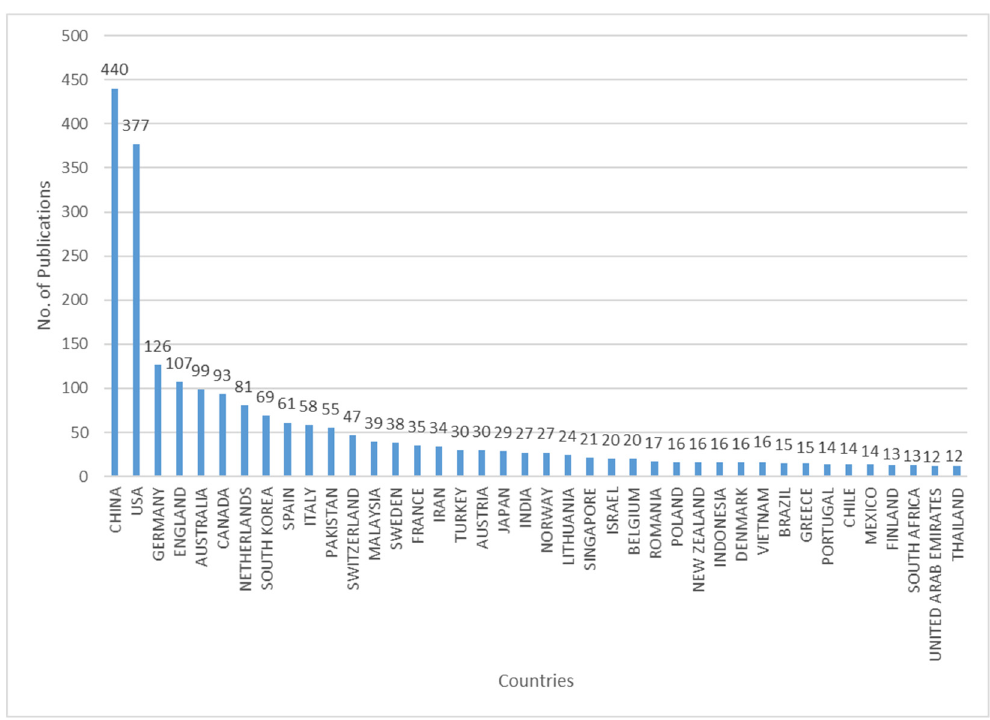
Figure 2. Geographical distribution of published papers.